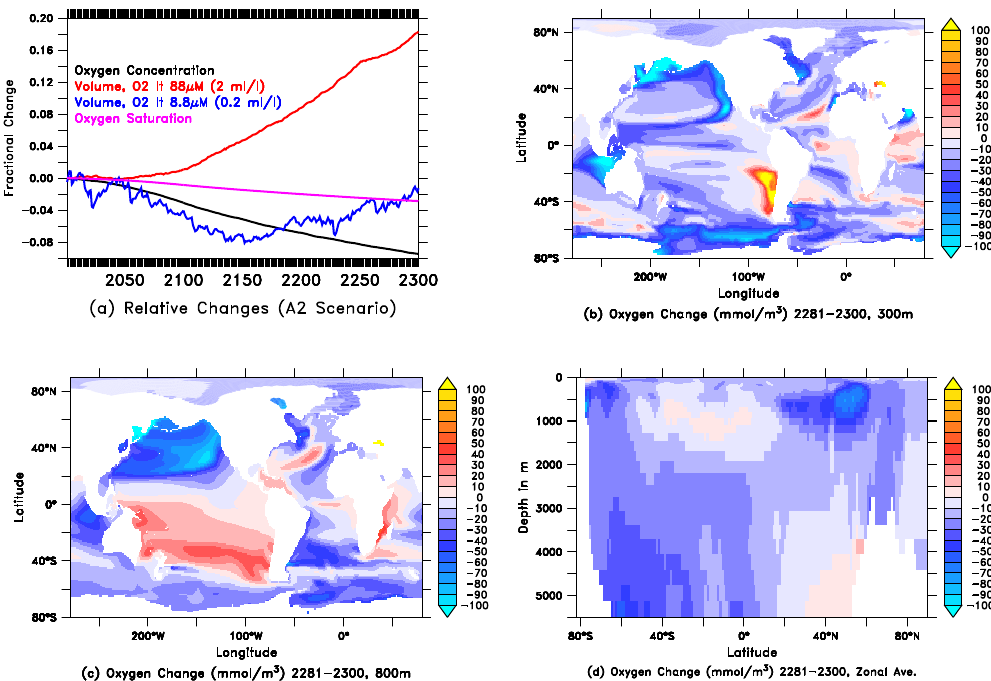
Fig. 2. Oxygen changes under the A2 scenario. (a) Relative changes in O 2 inventory (black line), O 2 inventory in equilibrium with the atmosphere (magenta line), volume of hypoxic water (red line) and volume of suboxic water (blue line) relative to years 1981–2000 of historical run. (b) O 2 change (mmolm − 3 ) at 300m depth betwen years 2281–2300 in A2 run and corresponding years from 1860 control. (c) O 2 change (mmolm − 3 ) at 800m depth between years 2281–2300 in A2 run and corresponding years from 1860 control. (d) Zonally averaged O 2 change (mmolm − 3 ) between years 2281-2300 in A2 run and corresponding years from 1860